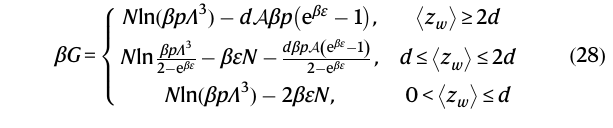
(cid:10) (cid:11)(cid:4) (cid:5) (cid:1) 1 .